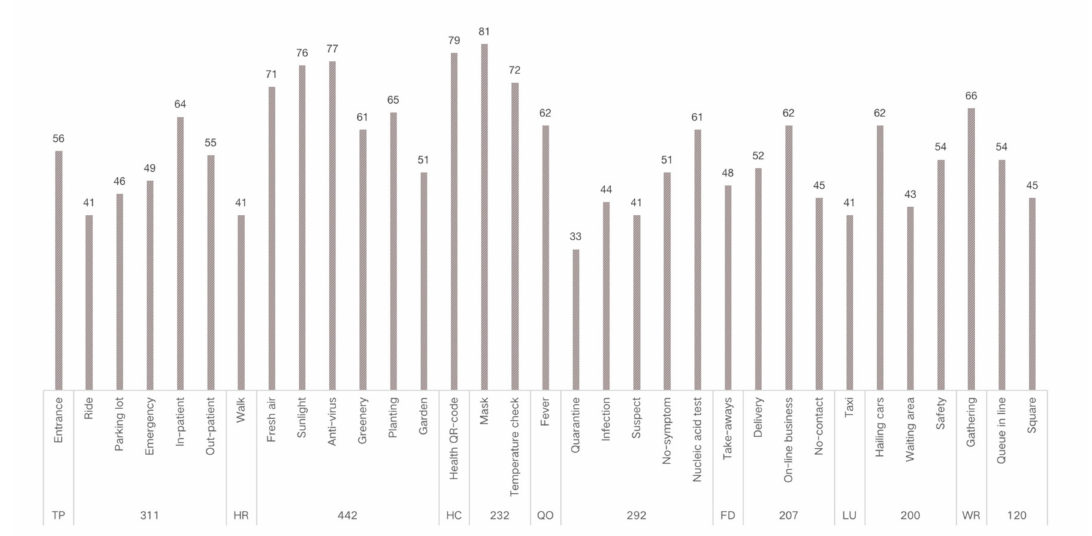
Figure 3. Frequency of